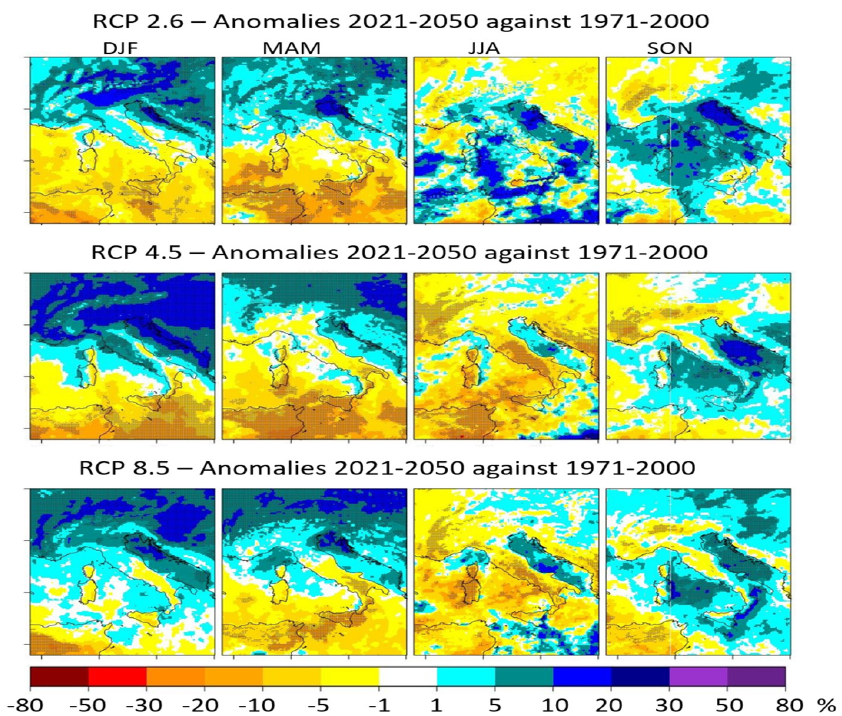
Figure 6. Seasonal Total precipitation anomalies (%) expected by 2021–2050 (DJF, MAM, JJA, SON, respectively, from first to fourth column), against the reference period 1971–2000, gathered by Euro-CORDEX ensemble models, under RCP 2.6 (top), RCP 4.5 (center), RCP 8.5 (bottom) configurations.